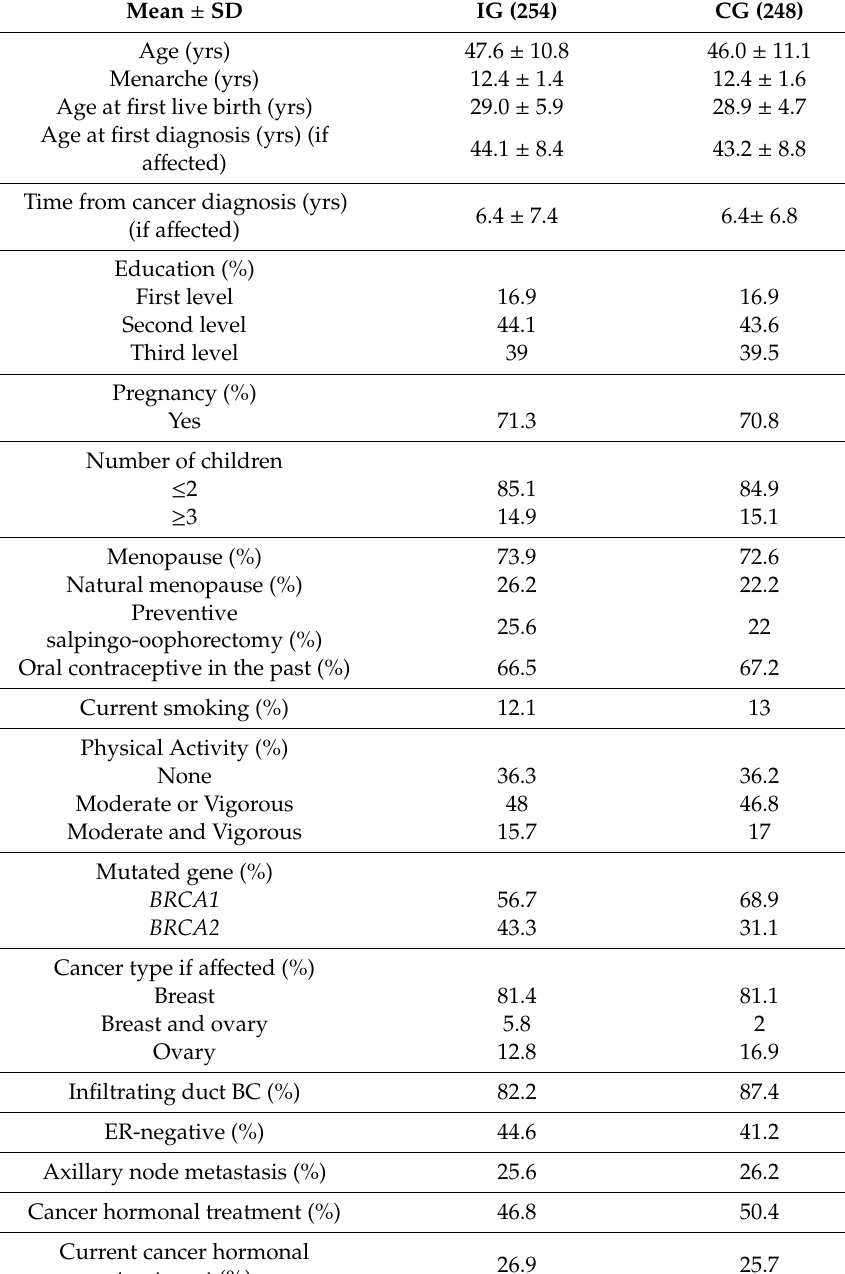
Table 1. Baseline characteristics of the study population (502